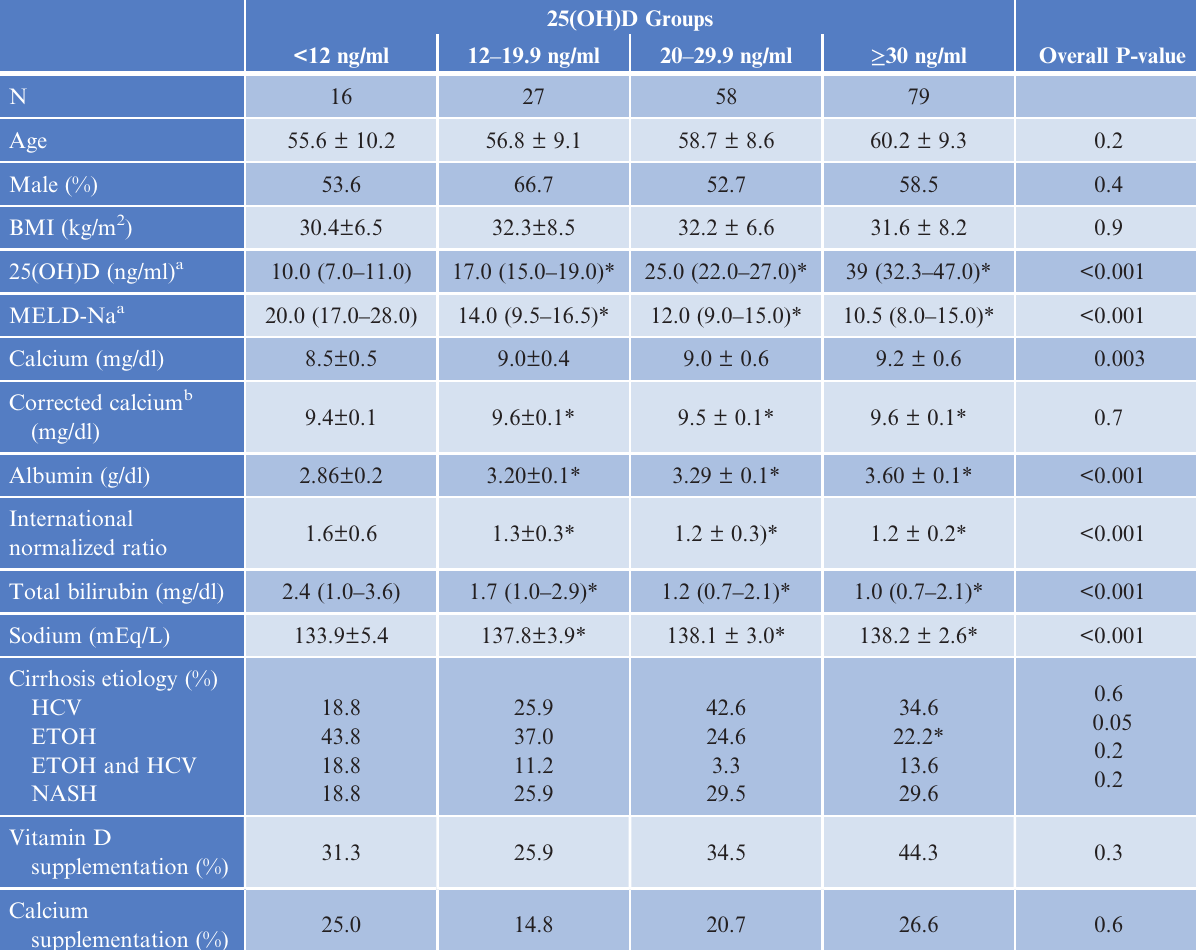
Table 2. Characteristics of patient participants by serum 25-hydroxyvitamin D [25(OH)D]